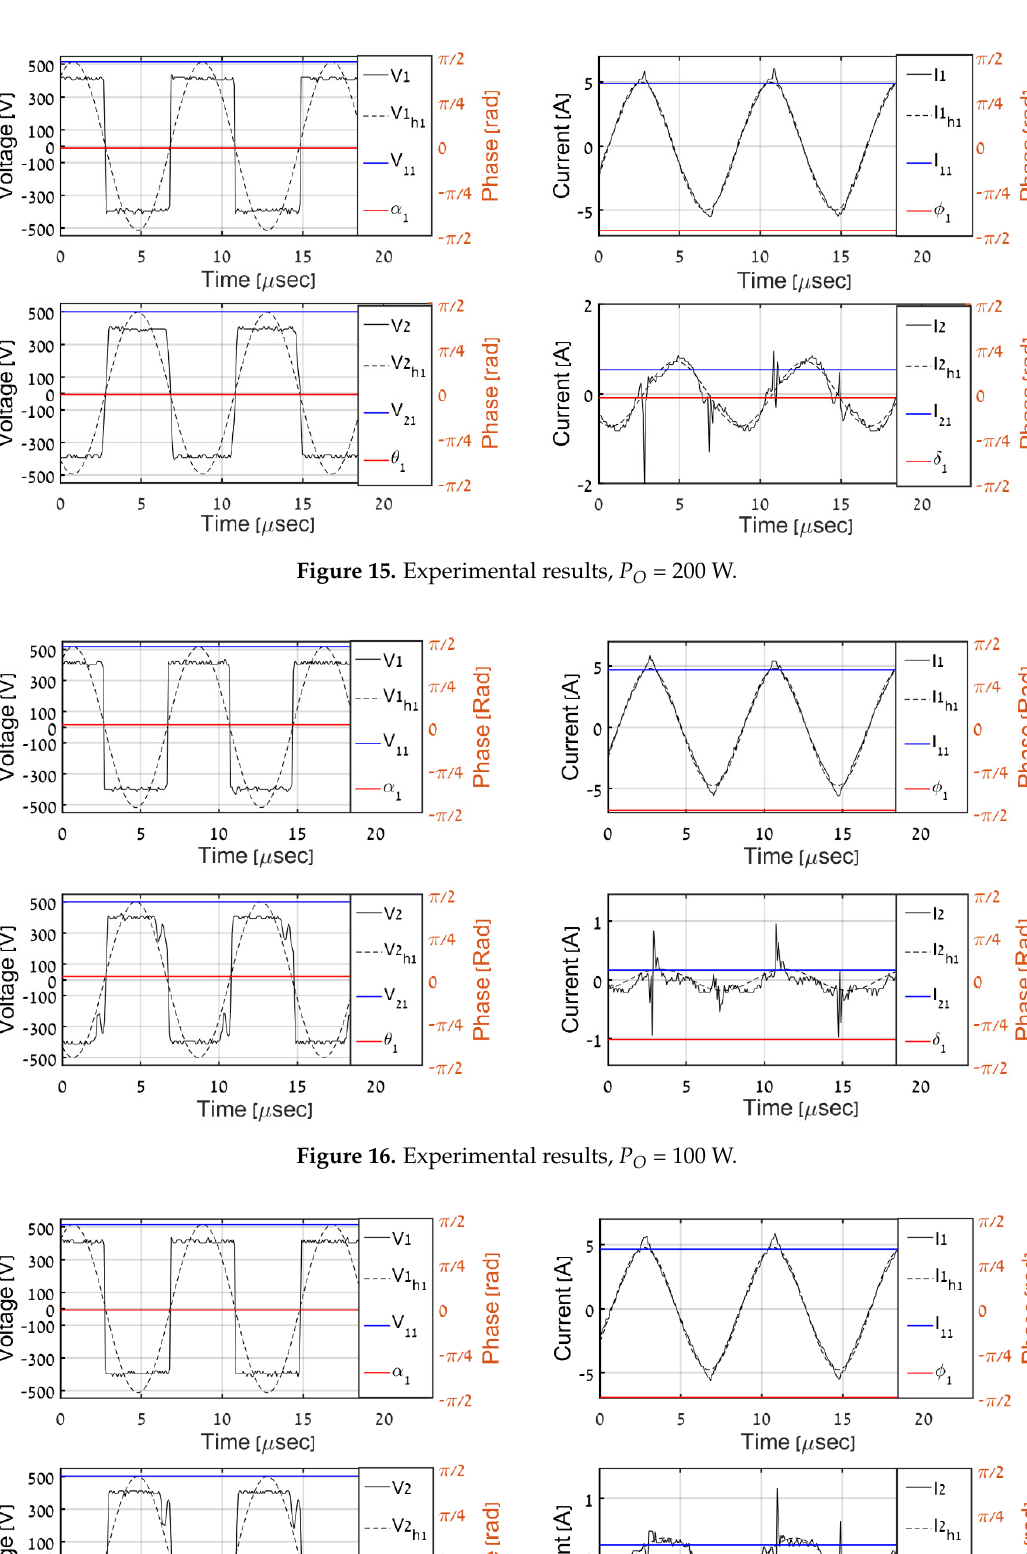
Figure 14. Experimental results, P O = 500 W.